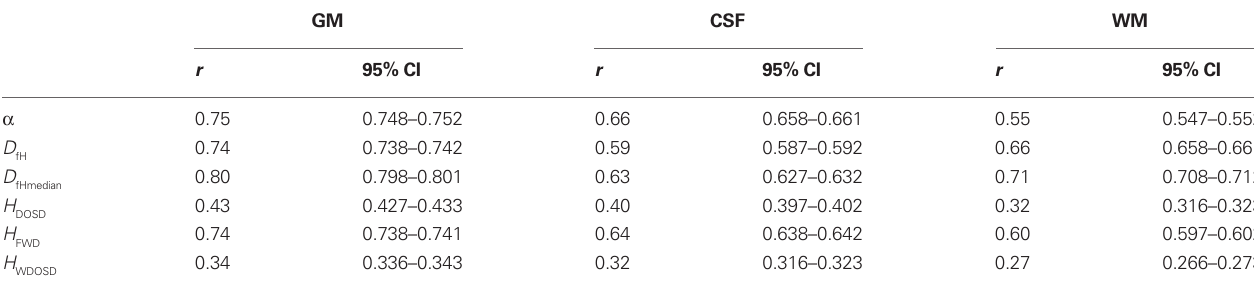
Table 3 | Correlation coeffi cients r with confi dence intervals computed between the group mean probabilistic tissue-segment maps and the 1-p maps describing signifi cant of group level changes in different metrics between Pre-HV and